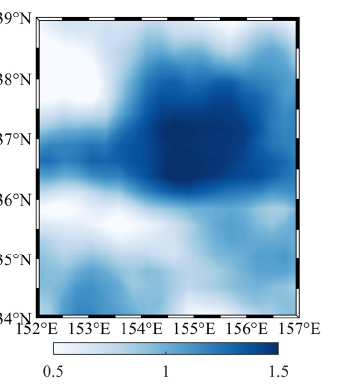
Figure 9. Annual range of sea level anomalies in the study area (unit: m).